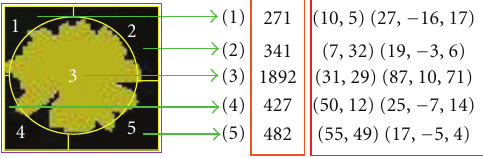
Figure 3: Color signature for the